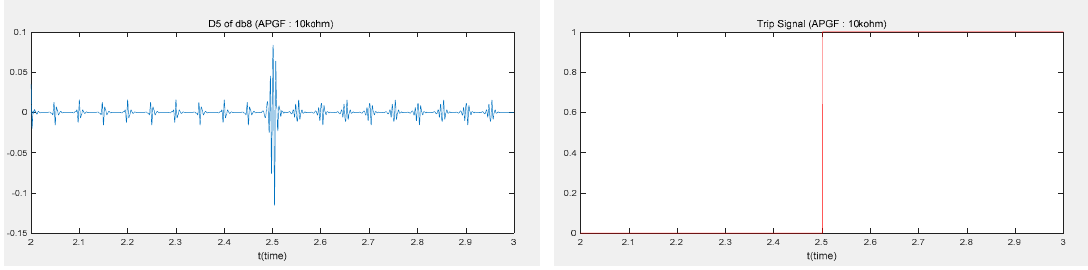
Figure 8. The simulation result under pole to ground ( PtoG).